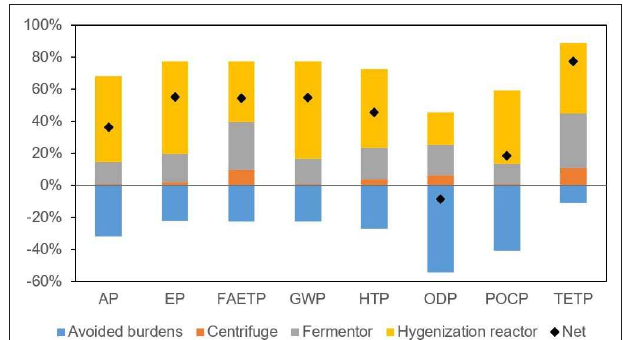
FIGURE 4 | LCIA results of the proposed food waste treatment system. AP, acidification potential; EP, eutrophication potential; FAETP, freshwater aquatic ecotoxicity potential; GWP, global warming potential; HTTP, human toxicity potential; ODP, ozone depletion potential; POCP, photochemical ozone creation potential; TETP, terrestrial ecotoxicity